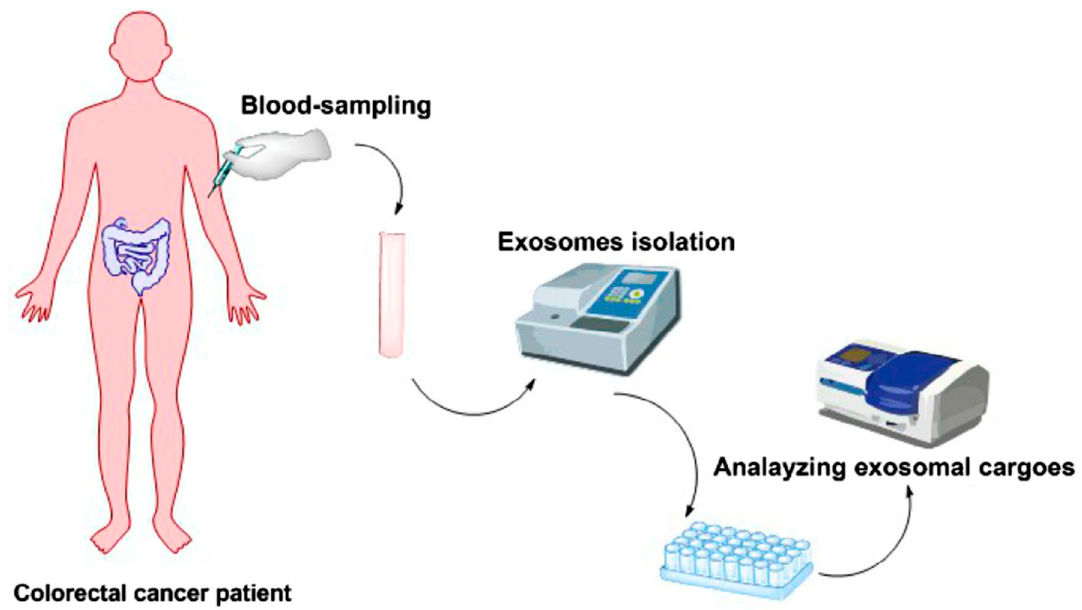
Figure 2. Method for highlighting types of biomarkers of colorectal cancer patient. Reprinted with permission from Ahmadi, M et al., 2021 [40].